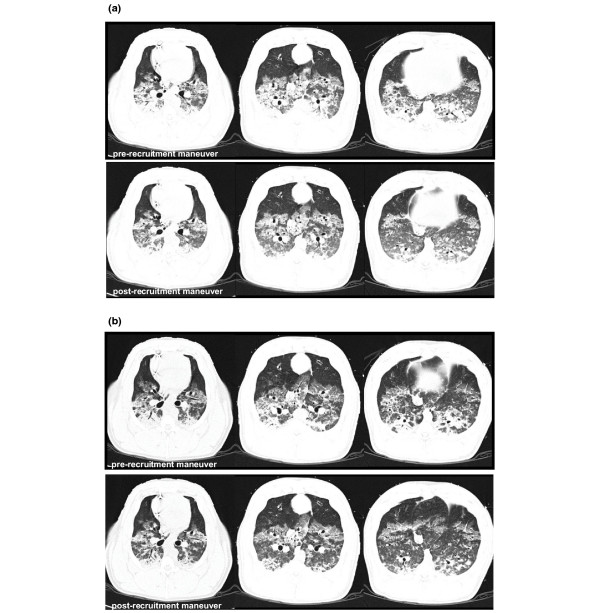
Representative CT scan of one animal at three different levels (apical, middle, basal). (a) Expiratory occlusion (10 cmH2O) before and after the recruitment maneuver. Lung volumes in this animal changed as follows: VHYP +1%, VNORM +15%, VPOOR +17%, VNON -30%, VGAS +11%. (b) Inspiratory occlusion at plateau pressure before and after the recruitment maneuver. Lung volumes in this animal changed as follows: VHYP +6%, VNORM +17%, VPOOR +26%, VNON -29%, VGAS +17%. VGAS, intrathoracic gas volume; VHYP, volume of hyperinflated lung parenchyma; VNON, volume of nonaerated lung parenchyma; VNORM, volume of normally aerated lung parenchyma; VPOOR, volume of poorly aerated lung parenchyma.